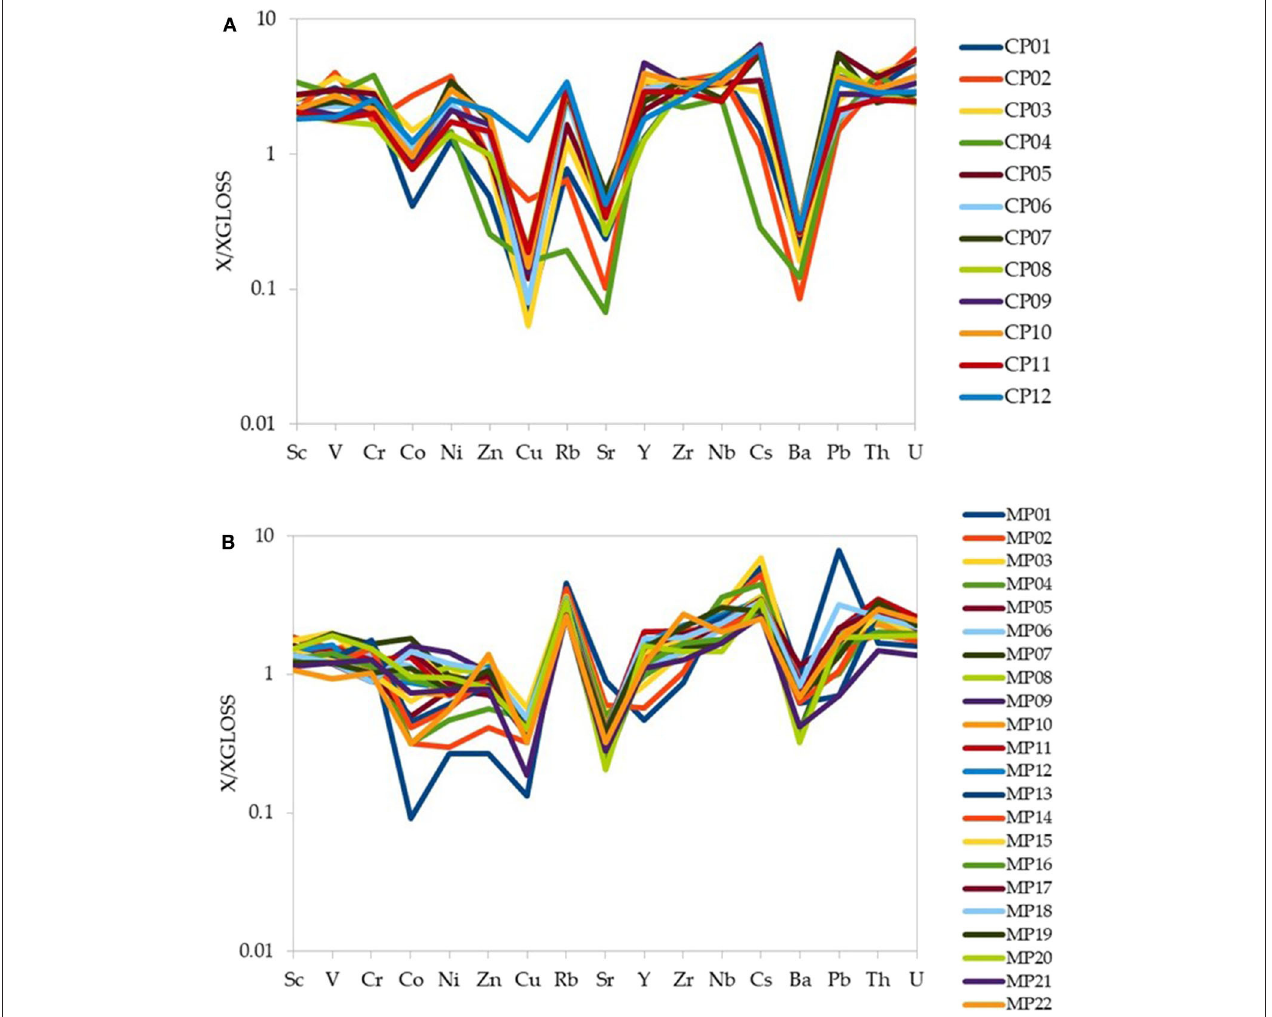
FIGURE 9 | GLOSS-normalized trace elements patterns of (A) the CP palaeosols, and (B) the MP palaeosols. GLOSS values are from Plank and Langmuir (1998).